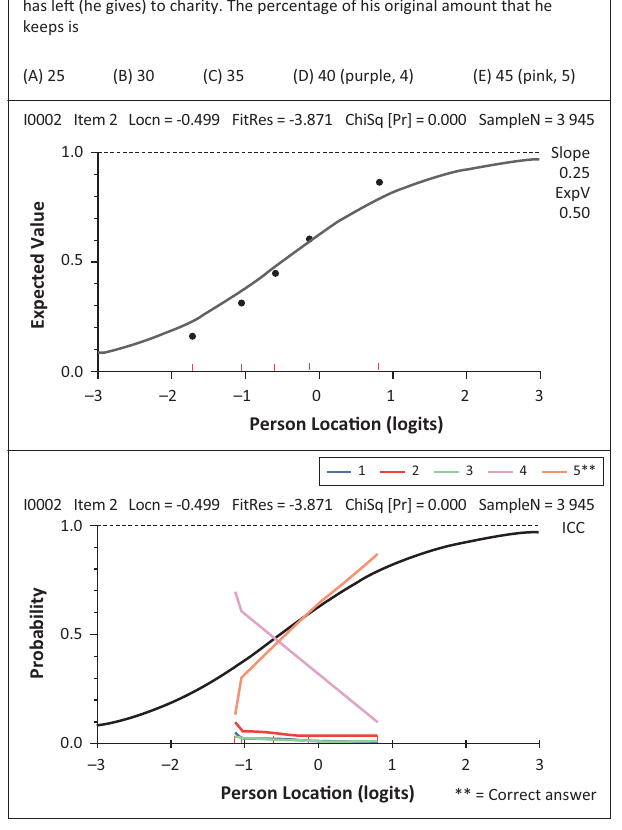
FIGURE 7: Item 6, with item characteristic curve, and multiple choice distractor plot.